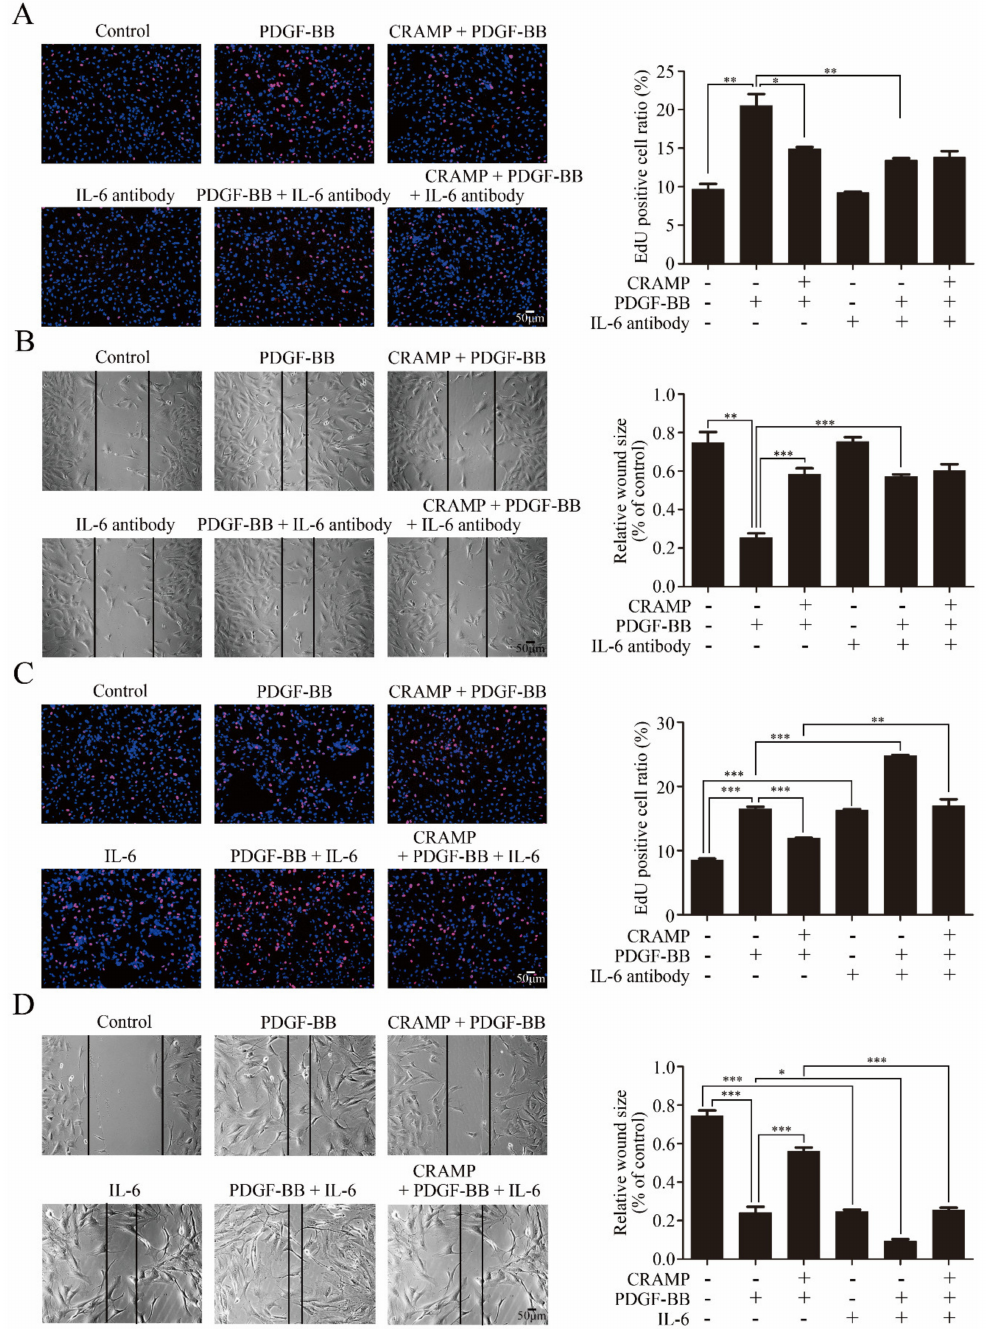
Figure 4. IL-6 / JAK2 / STAT3 cascades participated in CRAMP inhibited VSMC proliferation and migration. ( A ) VSMC were pretreated with IL-6 antibody (10 µ g / mL) for 2 h and CRAMP (100 ng / mL) for 2 h and then stimulated with PDGF-BB (20 ng / mL) for 24 h. The proliferation of VSMC was detected by EdU assay. ( B ) VSMC were pretreated with IL-6 antibody (10 µ g / mL) for 2 h and CRAMP (100 ng / mL) for 2 h and then stimulated with PDGF-BB (20 ng / mL) for 24 h. The migration of VSMC was detected by wound healing assay. ( C ) VSMC were pretreated with IL-6 (10 ng / mL) for 2 h and CRAMP (100 ng / mL) for 2 h and then stimulated with PDGF-BB (20 ng / mL) for 24 h. The proliferation of VSMC was detected by EdU assay. ( D ) VSMC were pretreated with recombinant IL-6 at final concentration of 10 ng / mL and CRAMP (100 ng / mL) for 2 h and then stimulated with PDGF-BB (20 ng / mL) for 24 h. Data of 3 independent experiments is presented as mean ± SEM. * p < 0.05, ** p < 0.01, *** p < 0.001 compared with control, n =